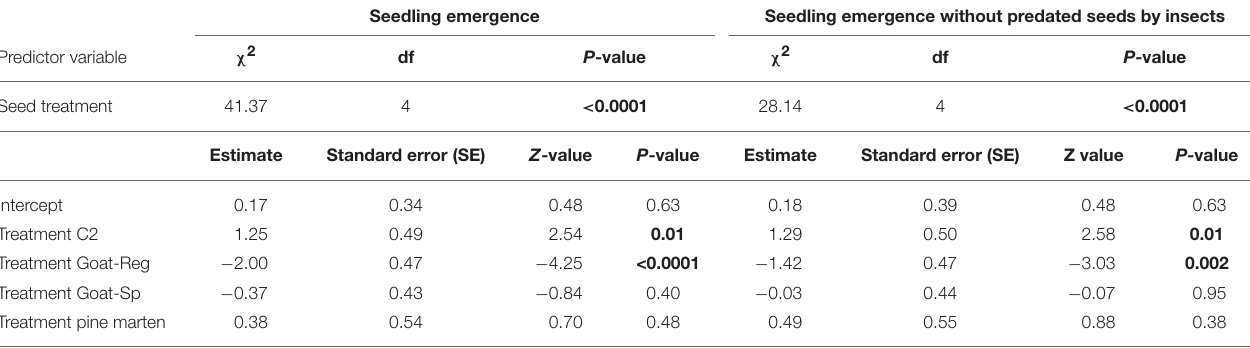
TABLE 2 | Main results of the generalized linear mixed models testing the effects of emergence success, with and without predated seeds by insects (response variable), for each treatment (C1 or “control seeds with pulp”, C2 or “manually-depulped control seeds”, Goat-Reg or seeds regurgitated by goat, Goat-Sp or seeds spit out by goat, and Pine marten or pine marten-ingested seeds) (predictor variable).